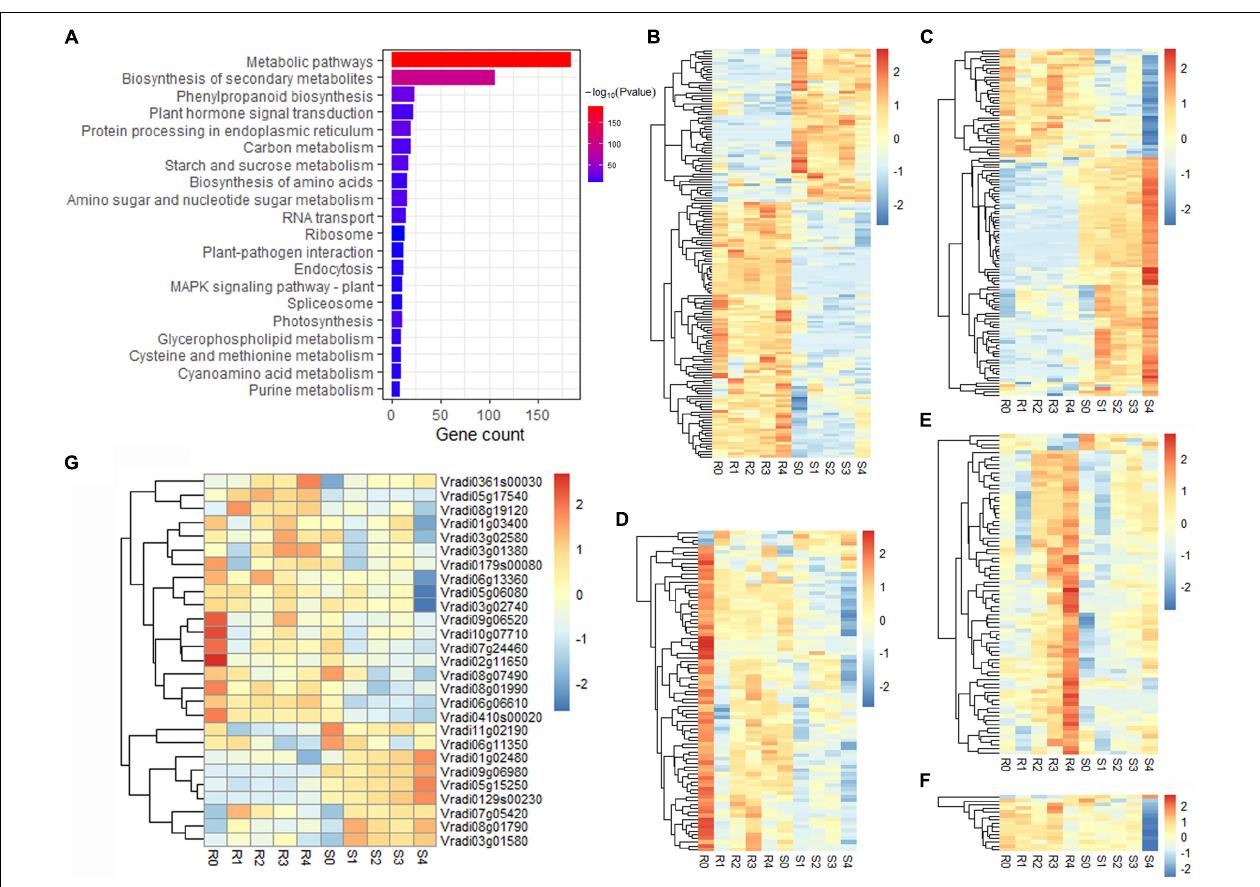
FIGURE 4 | Functional and expression pattern analyses of DEGs in five modules (red, pink, grey60, tan, and paleturquoise) related to Fusarium wilt resistance. (A) KEGG enrichment of DEGs in five modules related to Fusarium wilt resistance. (B-F) Expression patterns of co-expressed genes in the red (B) , pink (C) , grey60 (D) , tan (E) , and paleturquoise (F) modules, respectively. (G) Expression patterns of 27 candidate